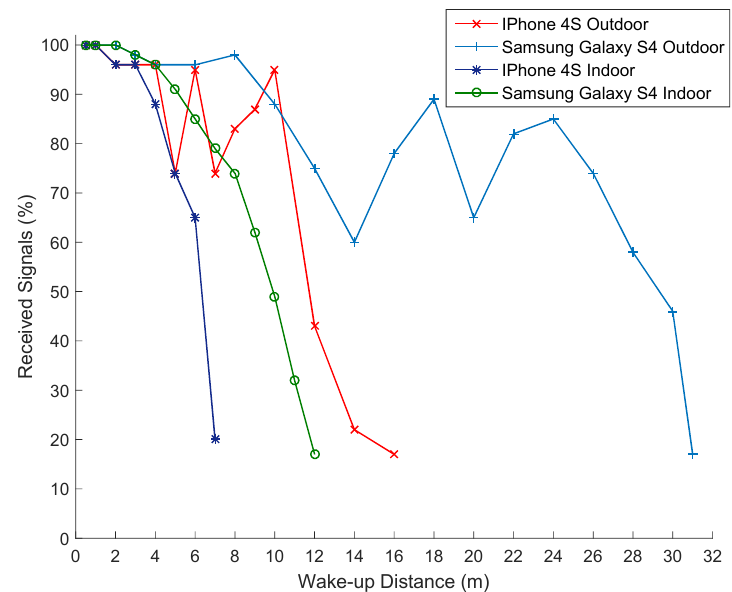
Figure 9. Wake-up signals’ successful reception rate for a Samsung Galaxy and an iPhone.